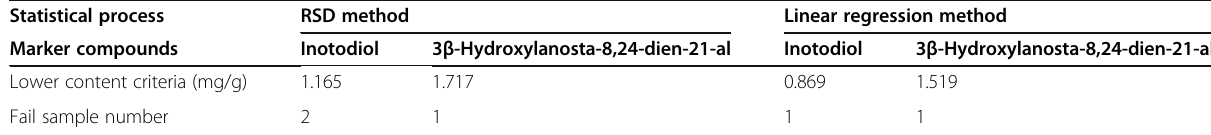
Table 2 Content criteria of I. obliquus mushroom depending on statistical methods ( n = 10) Statistical